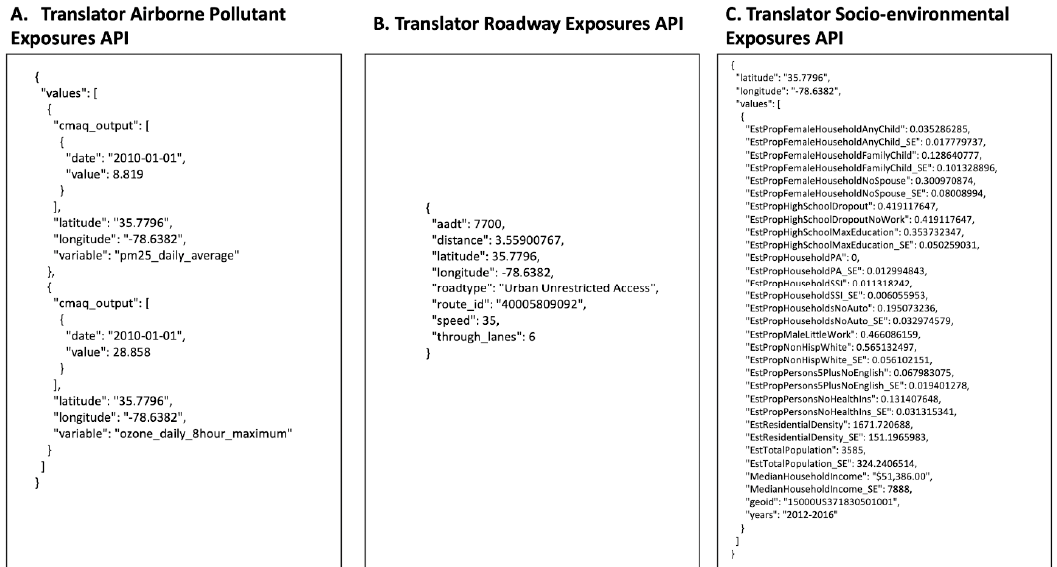
Figure 2. Example JSON output for Raleigh, North Carolina (latitude, longitude: 35.7796, − 78.6382)